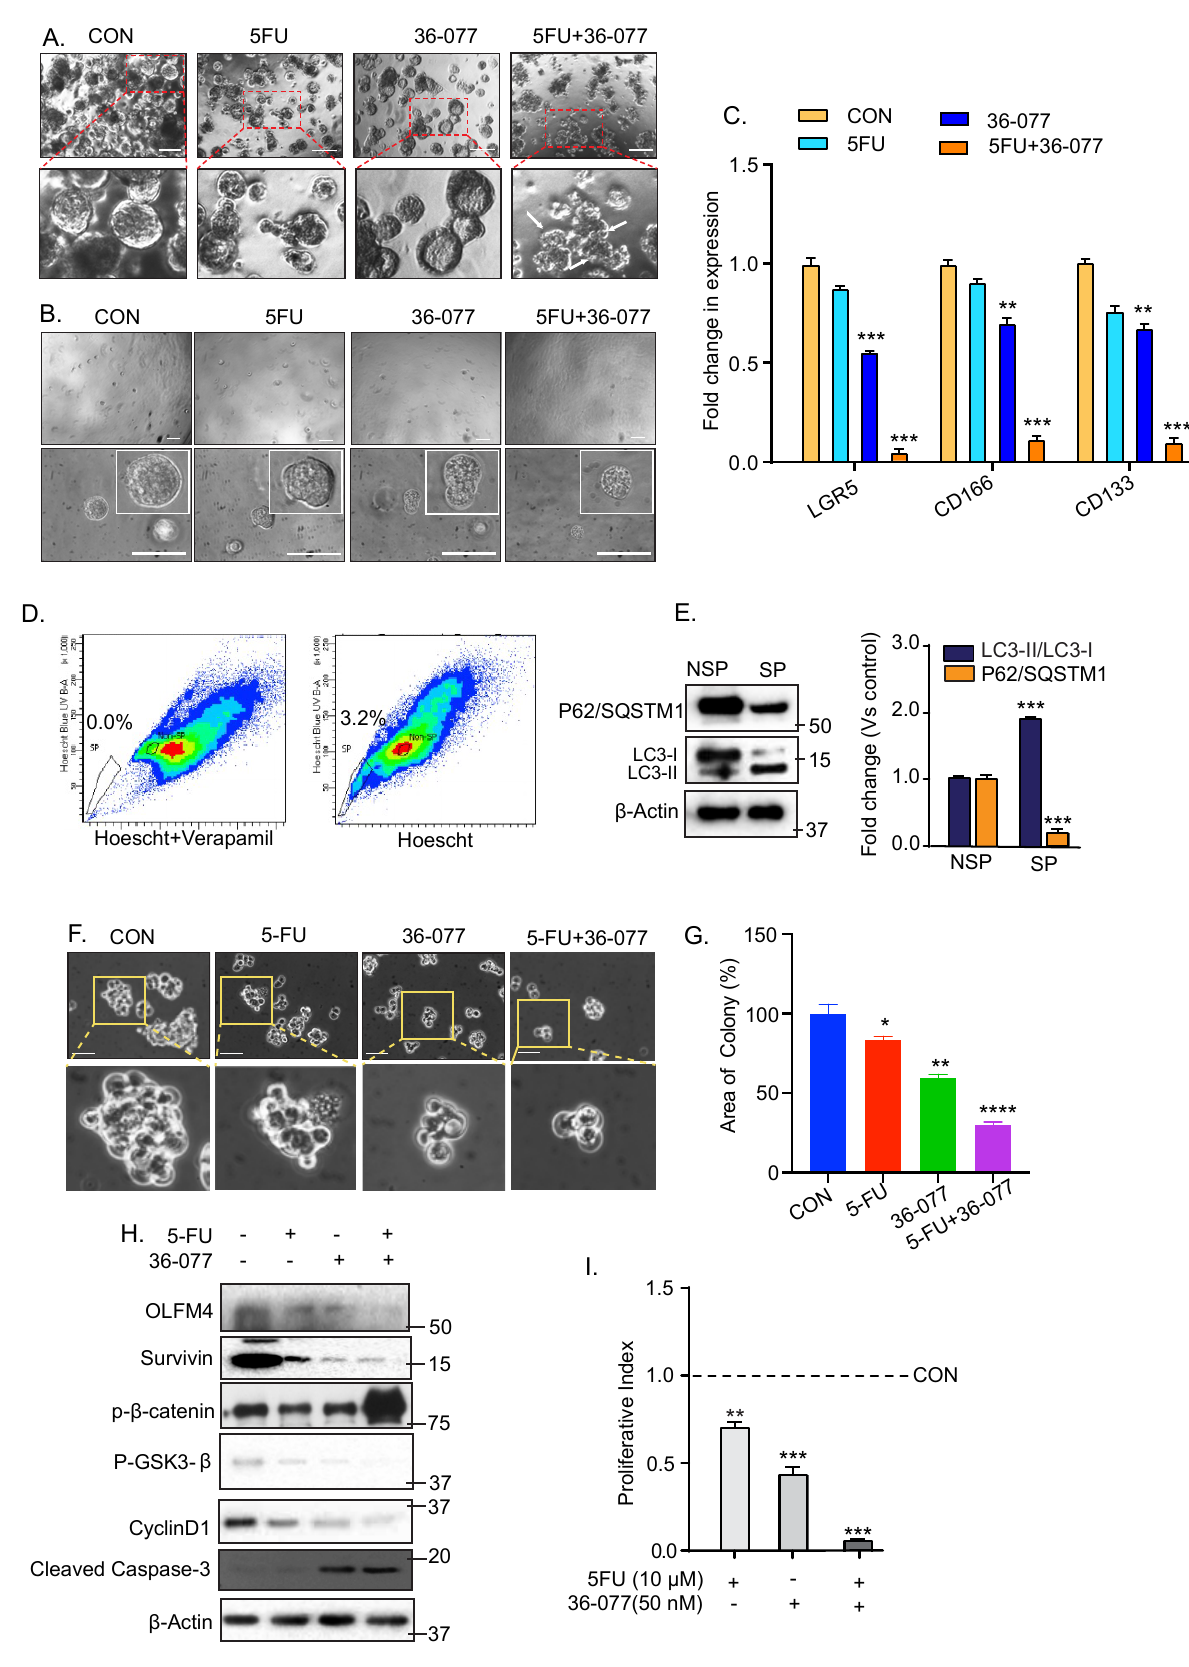
Figure 6. Combination treatment of 5-FU and 36-077 inhibits cancer stem cells. Single cells suspension of Caco-2 cells